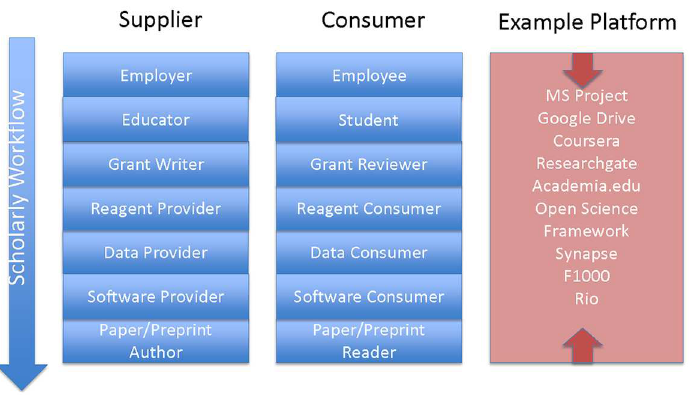
Fig 2. Example platforms currently supporting biomedical